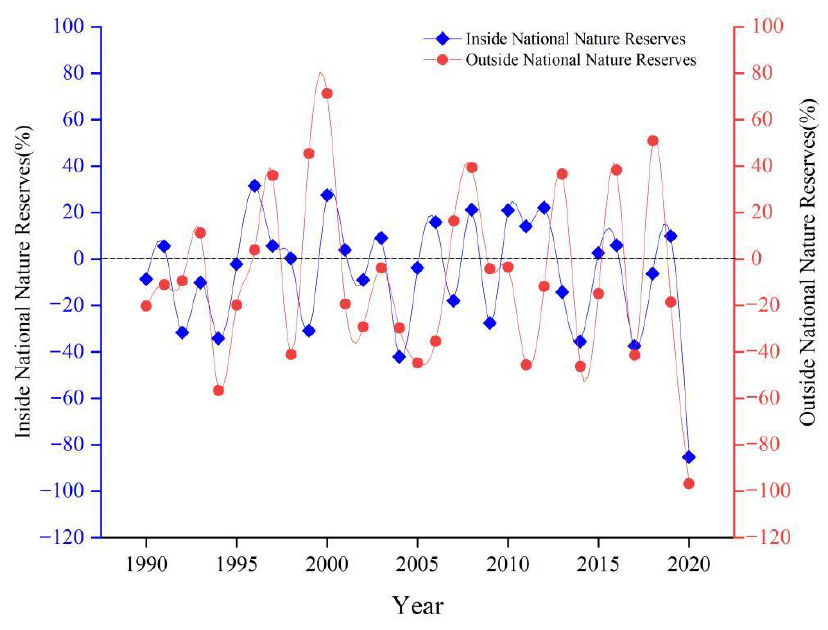
Figure 9. Change rate of S. salsa inside and outside National Nature Reserves.